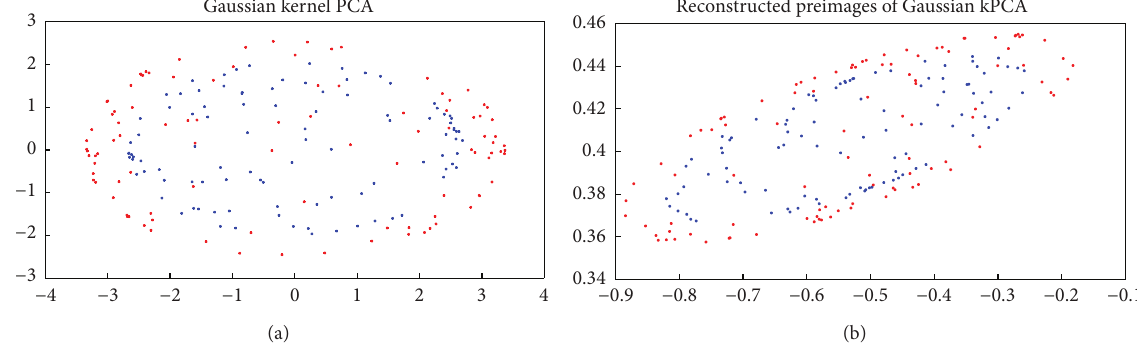
Figure 3: Feature extraction: (a) KPCA feature using Gaussian mapping, (b) restructured image of